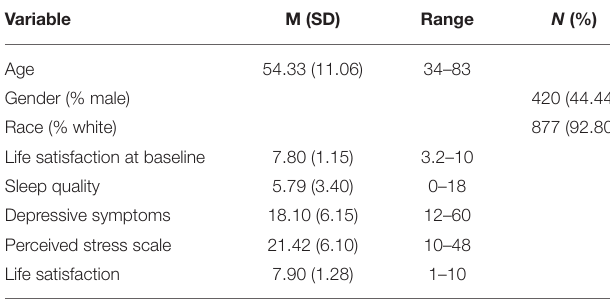
Covariates TABLE 1 | Descriptive statistics for sample ( N =